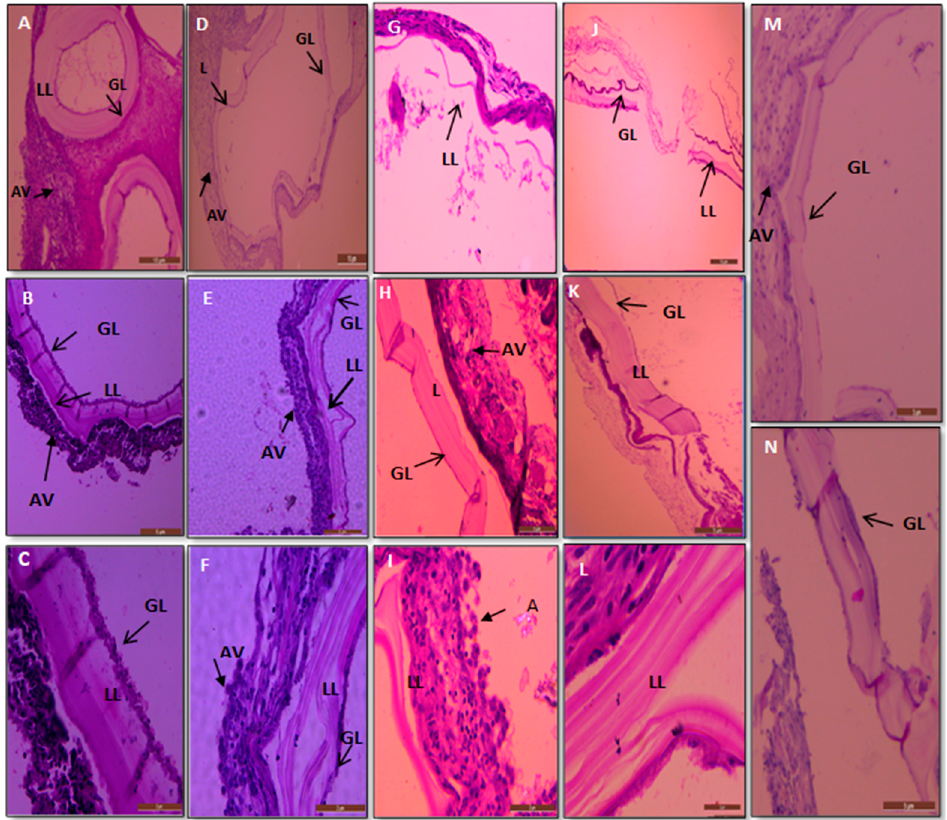
Figure 10. Sections of cysts treated with 200 mg/kg AgNPs and untreated (control) infected mice. ( A – C ) Represent the control untreated mice hydatid cyst; the LL is tight and thick and GL is intact. ( E , F , L ) Show treated hydatid cysts from infected mice which were treated with AgNps, and LL became loose with vascular appearance. ( D , K , I ) Show that the LL is thinner and separated from the germinal layer. ( G , J ) Show the hydatid cysts layer destroyed. ( H , M , N ) Show the GL destructed and reduced cells. GL: germinal layer; LL: laminated layer; AV: adventitious layer. Stained with hematoxylin and eosin. Scale bar = 2 μ m & 10 μ m.